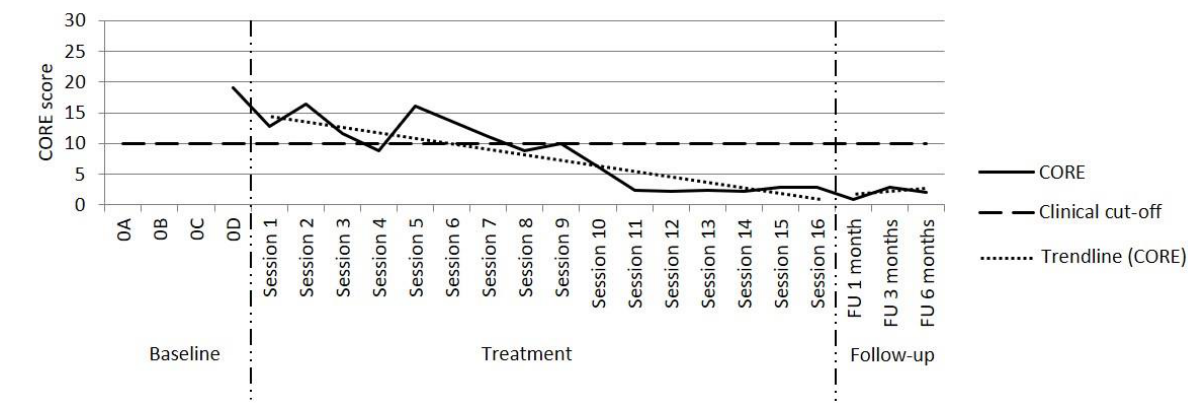
Figure 2: Margherita’s weekly anxiety (GAD-7) score